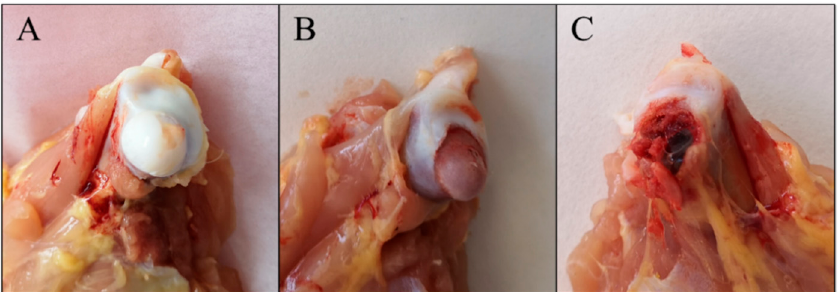
Figure 1. The macroscopic morphological changes for different degrees of femoral head necrosis (FHN). ( A ) The normal femoral head with an integral structure. The FHN evaluation score is set to 0. ( B ) The femoral head separates from the growth plate. The FHN evaluation score is set to 1. ( C ) Rupture of the femoral head. The FHN evaluation score is set to 2.